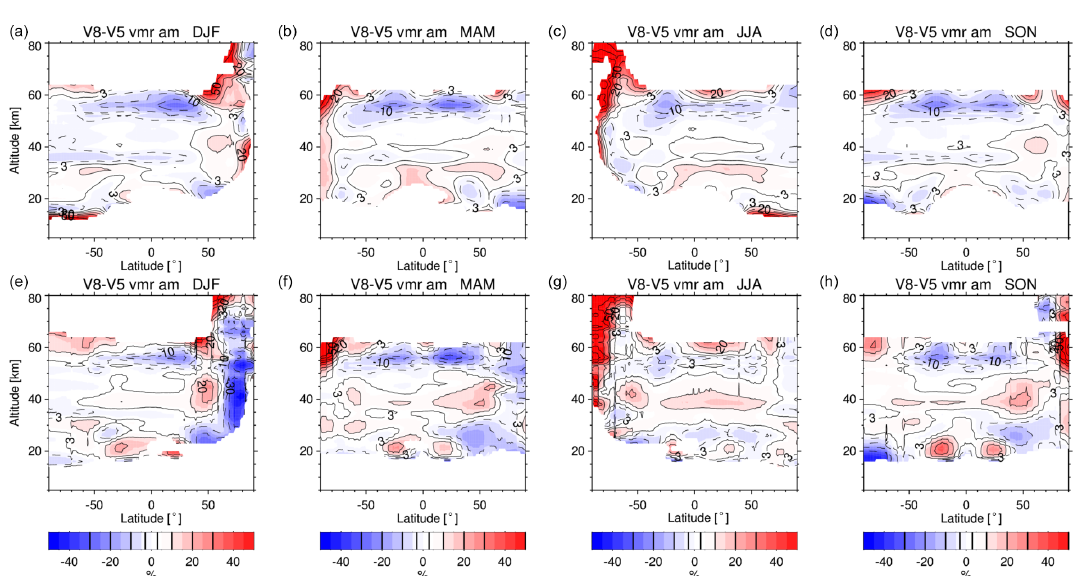
Figure 11. Seasonal composite zonal mean distributions of the relative NO vmr differences between version 8 and version 5 as a func- tion of latitude and altitude for (a–d) NOM RR and (e–h) NOM FR morning observations. Specifically, version 5 data used here